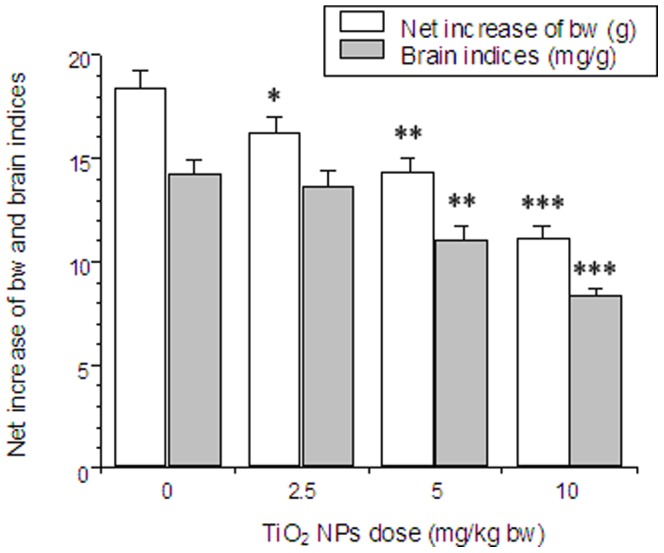
The net increase in the coefficient of brain to body weight in mice caused by nasal administration of TiO2 NPs for 90 consecutive days.Bars marked with an asterisk, double asterisks or three asterisks means it is significantly different from the control (unexposed mice) at the 5, 1, and 0.1% confidence level, respectively. Values represent means ± D (N = 10).